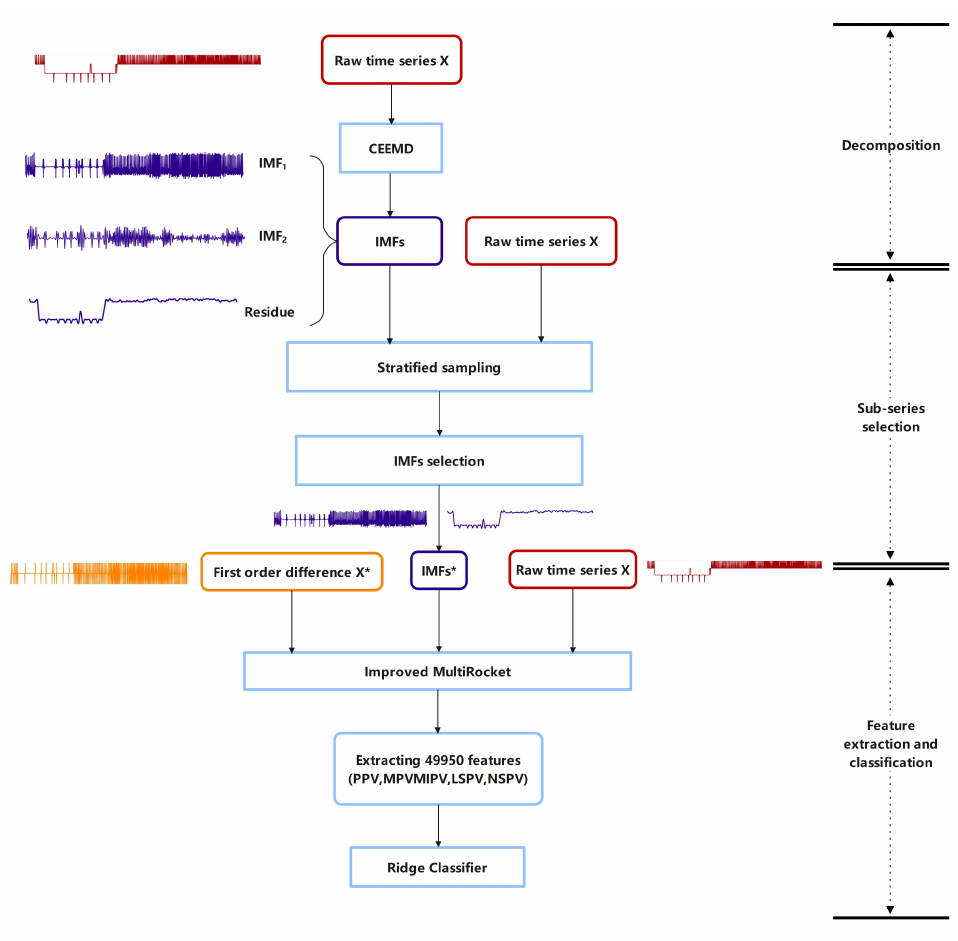
Figure 1. The flowchart of the proposed